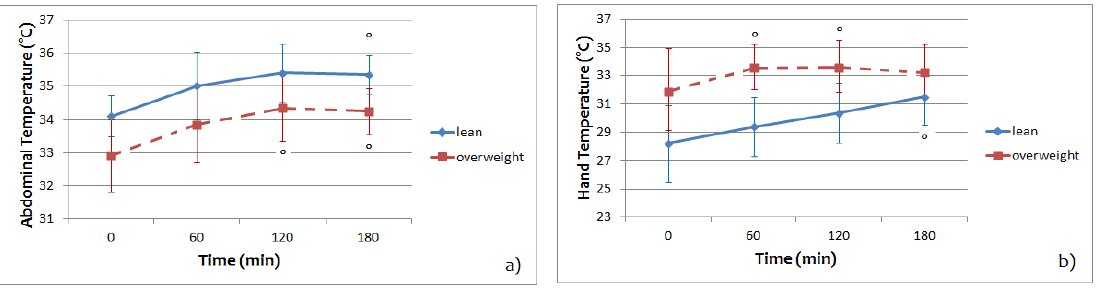
Figure 4. Abdominal ( a ) and hand ( b ) temperature values averaged on five lean subjects and on five overweight subjects, together with the 95% confidence intervals, during oral glucose tolerance test (OGTT).